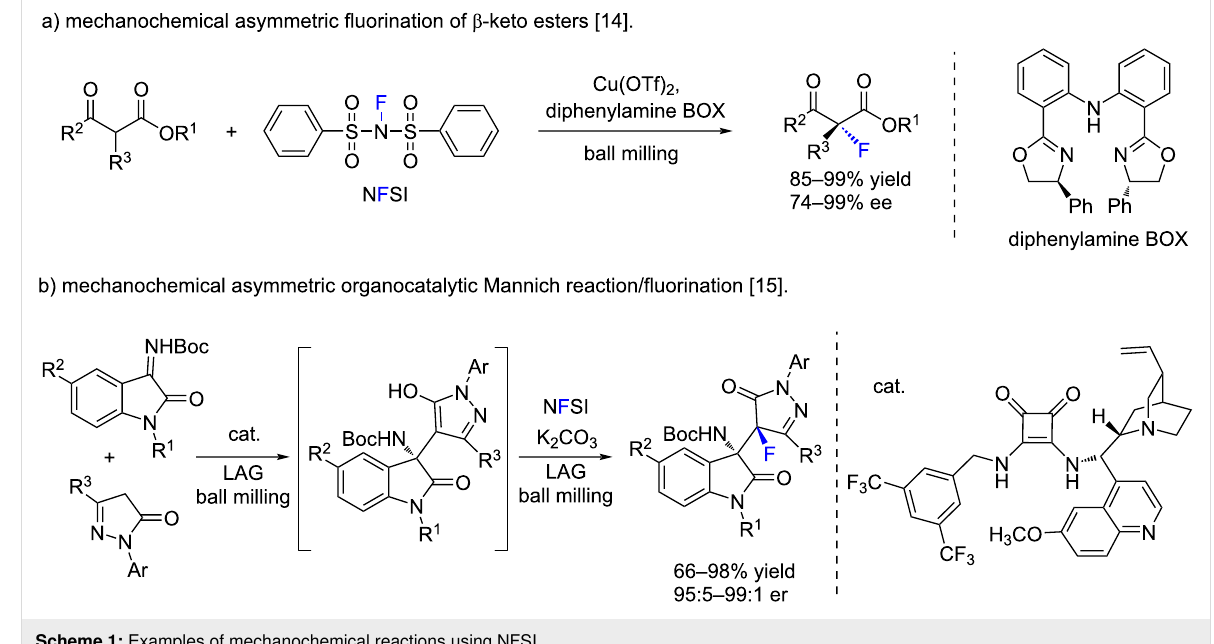
Scheme 1: Examples of mechanochemical reactions using